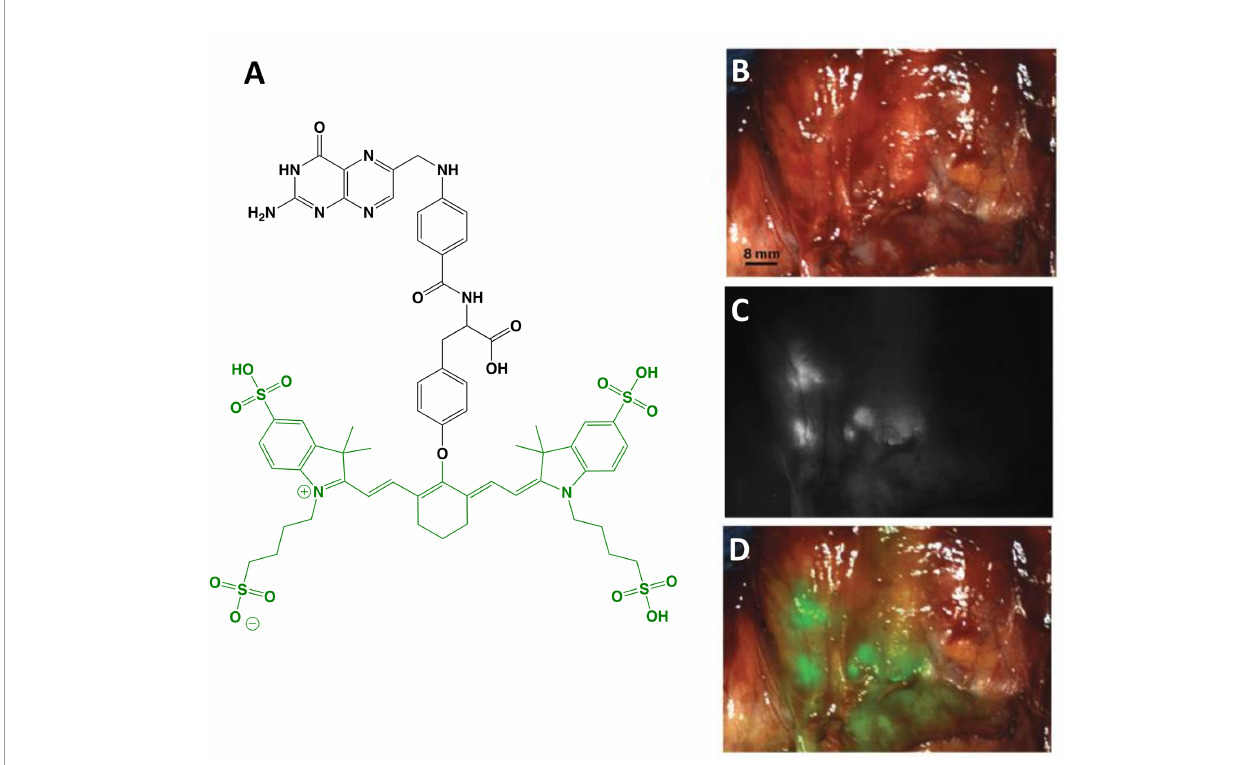
FIGURE 1 | OTL38. Chemical structure; folate motif (ligand) and linker in black, S0456 (dye) in green (A) . Intraoperative detection of ovarian cancer metastases with OTL38 administered 2-3 h prior to surgery: white-light only (B) , NIRF only (C) and white-light with NIRF overlay (D) . Panels (B – D) are adapted from (30) with